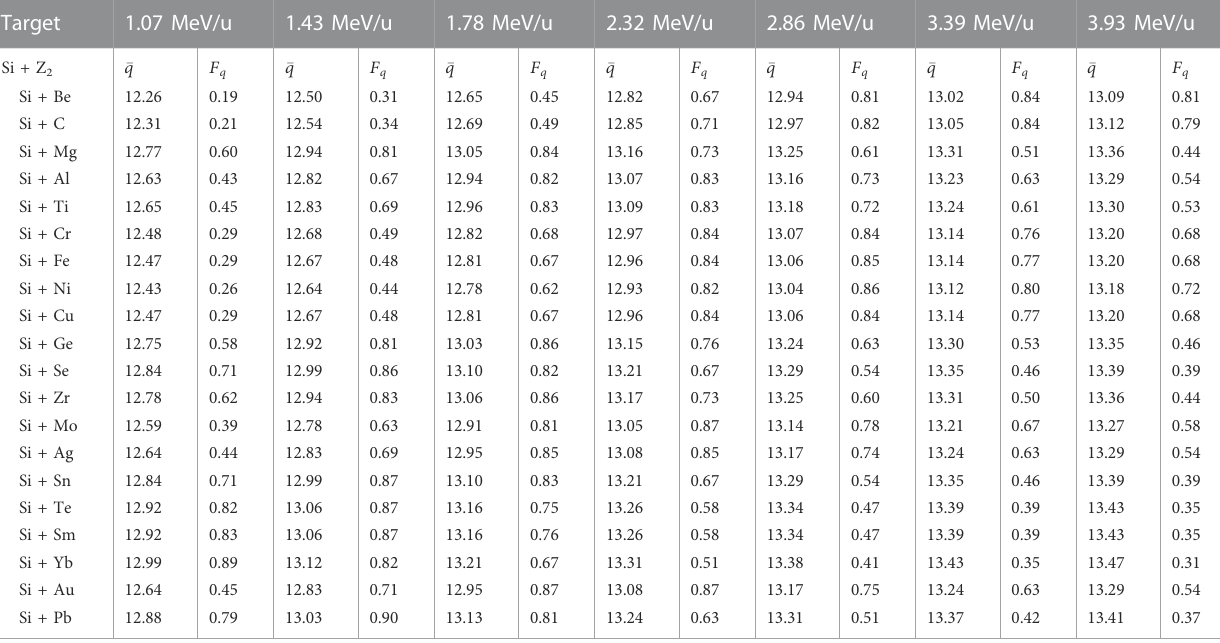
TABLE 1 Charge state fraction of H-like Si (Si +13 ) obtained from F-G-M [18] in different target elements and at different kinetic energies of the Si ion beam.